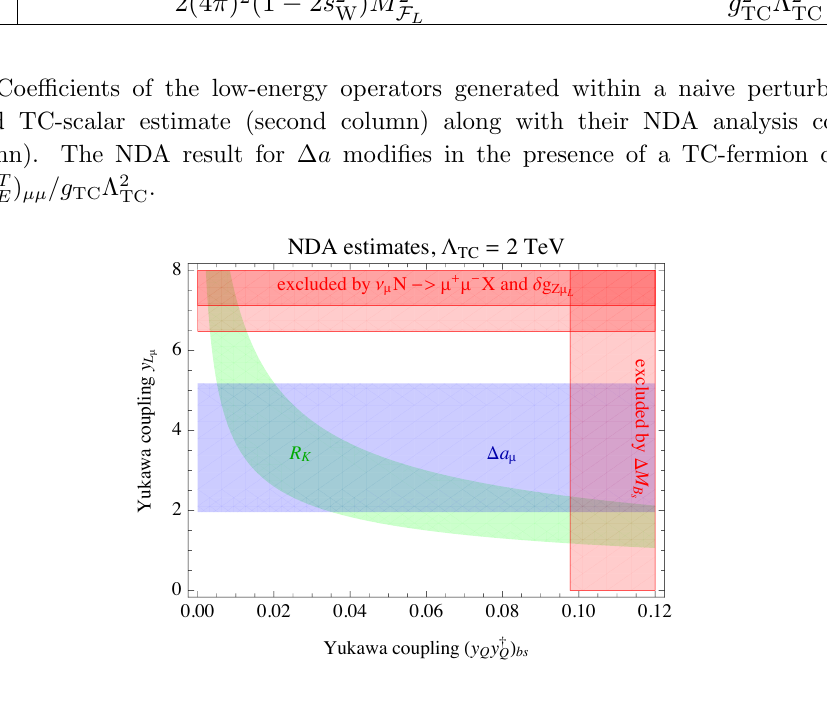
Figure 8 . Estimates of signals and bounds on the Yukawa couplings of fundamental composite Higgs models. The model generates an e(cid:11)ective operator that can simultaneously account for both R K and R K (cid:3) , so only R K is